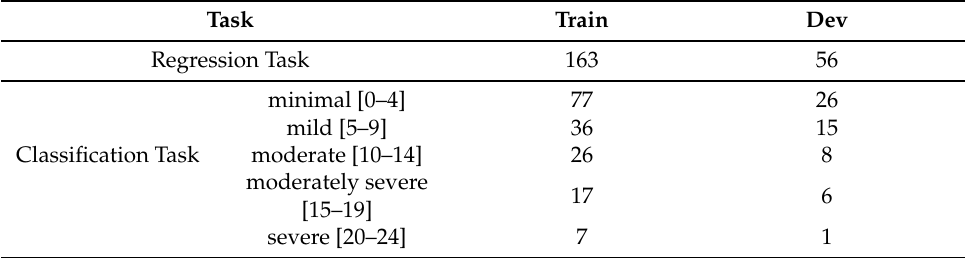
Table 1. Distribution of Training and development splits with the relationships between 5-class classification labels and PHQ-8 regression